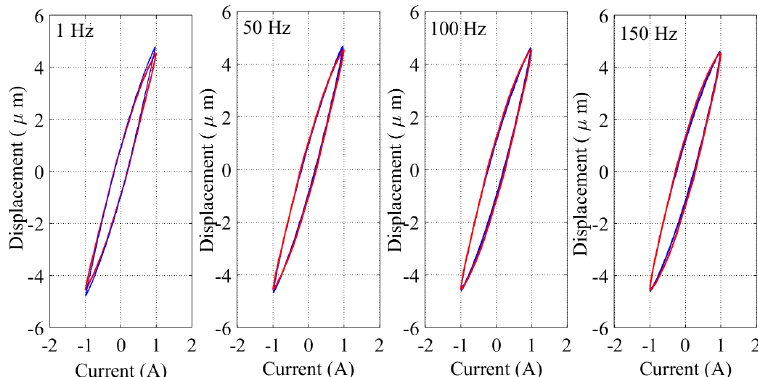
Figure 7. Comparison of experimental data and the model.